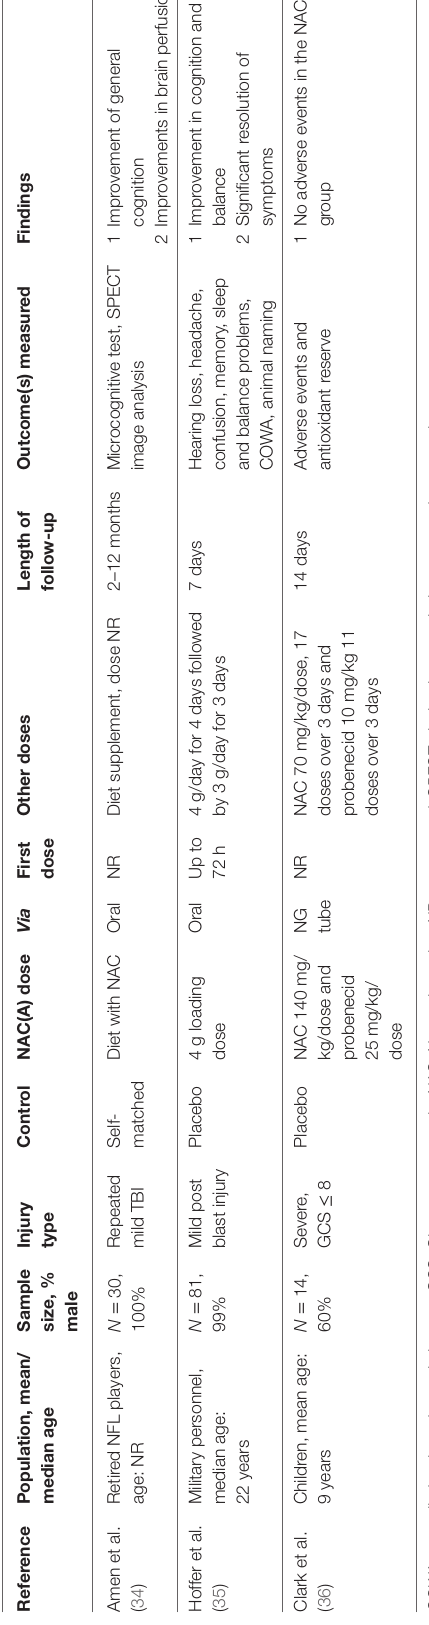
MeSH headings and the keywords “acetyl-cysteine” or “acetyl- cysteine” or “cysteine hydrochloride” or “cystine l-cysteine” or “NAC” or “ N- acetyl-B-cysteine” or “ N- acetyl-l-cysteine” or “ N- acetylcysteine” AND “brain injury” or